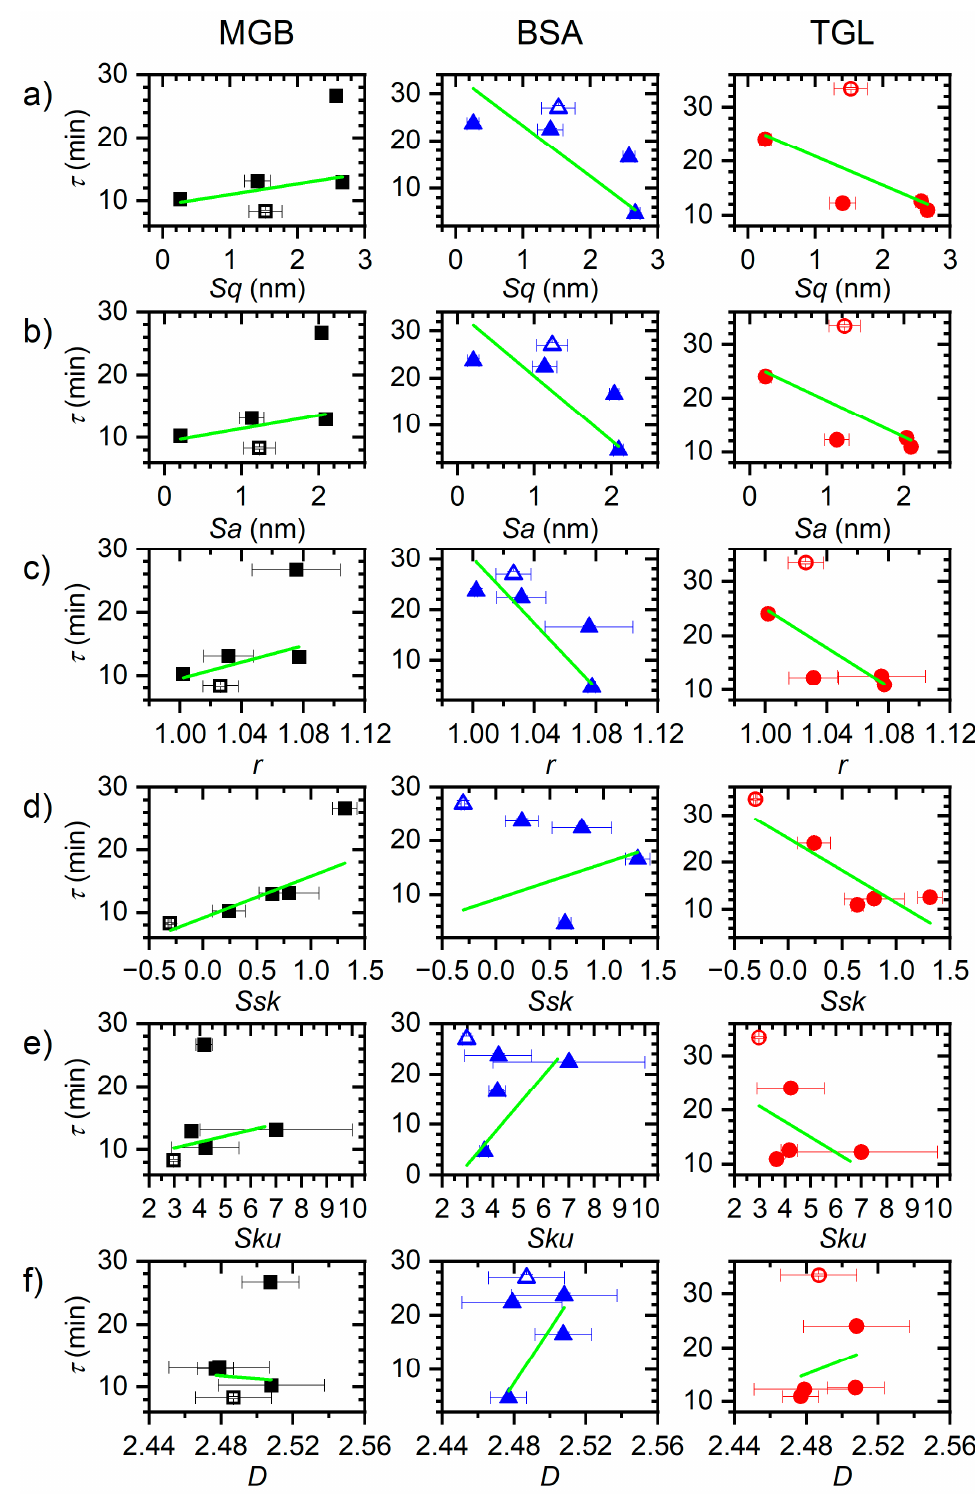
Figure 3. Time constant of adsorption τ of MGB, BSA, and TGL determined by fitting the ellipsometry data in Figure 2 (see Figures S3–S7) versus RMS surface roughness Sq ( a ), arithmetic surface roughness Sa ( b ), roughness factor r ( c ), skewness Ssk ( d ), kurtosis Sku ( e ), and fractal dimension D ( f ). Error bars in x direction reflect the standard deviations given in Table 2, whereas error bars in y direction represent the errors of the exponential fits. The nanorippled surfaces (0.07-40-r) are indicated by the empty symbols. The solid green lines represent linear fits to the data.